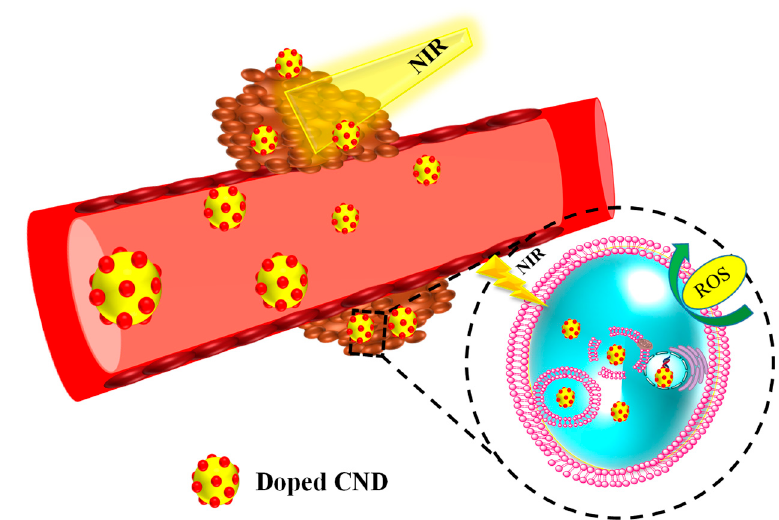
Figure 2. Doped CND-based nanostructures for PDT for